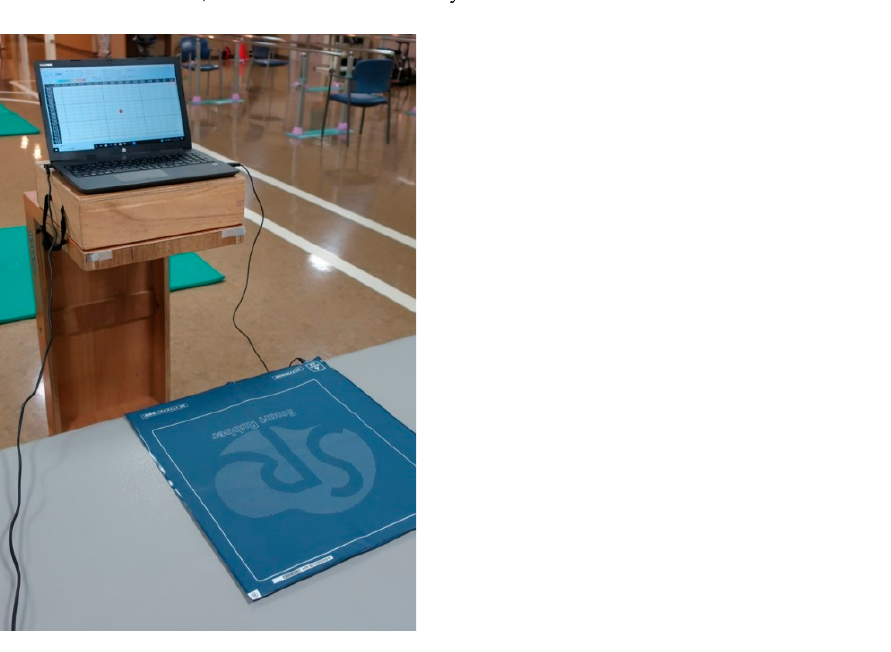
Figure 1. The Smart Rubber Soft Vision is a sheet-shaped apparatus that can be connected to a computer to perform posturographic examination and intervention using the center of